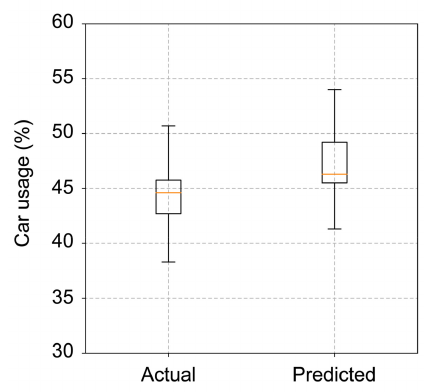
Figure 11. Actual and predicted car usage based on K-fold cross